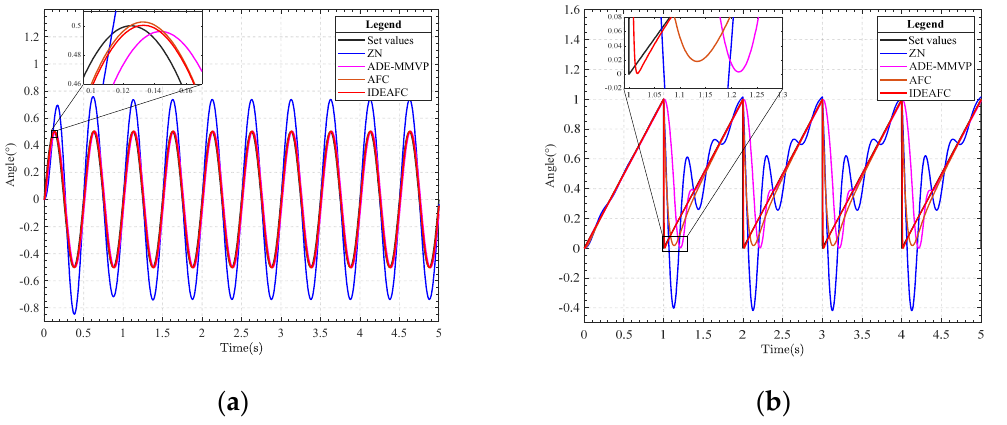
Figure 8. ( a ) Comparison curve of sine signal response of speed ring; ( b ) comparison curve of sawtooth wave response of speed ring gravimeter.